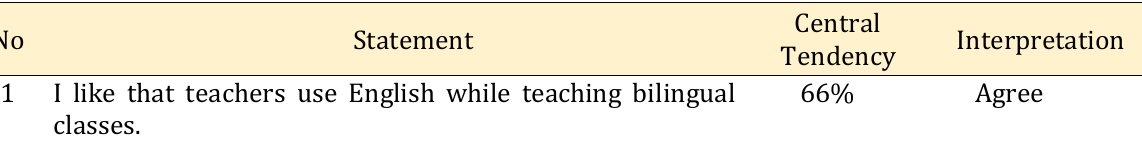
Table 1. statement 1 questionnaire and interview